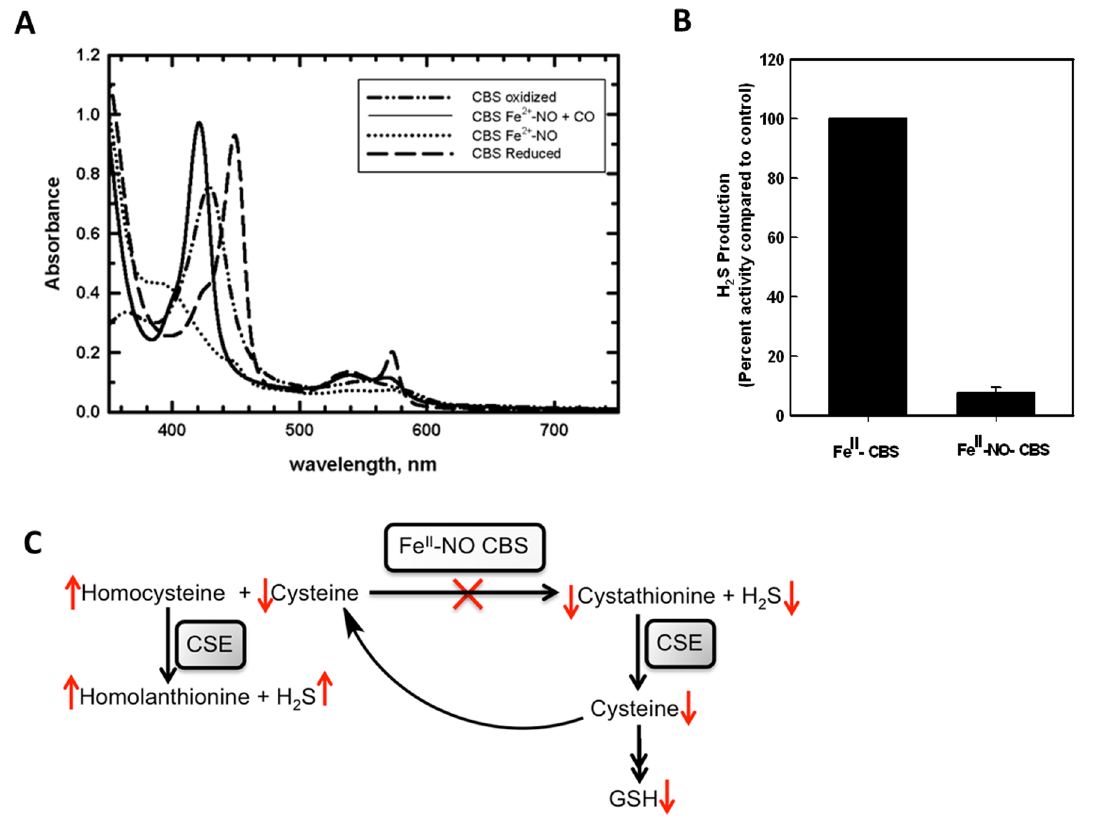
NN Figure 4. Reversible generation and metabolic consequences of Fe II -NO CBS. ( A ) Reduction of Fe III -CBS (10 m M) in 0.1 M HEPES buffer, -) with dithionite (3 mM) yields Fe II -CBS (–). The latter reacts with 10 mM nitrite to give Fe II -NO CBS ( …. ). The NO ligand is exchanged for pH 7.4, (- CO upon incubation of the reaction mixture for 10–15 min with CO (––). ( B ) Effect of NO binding to Fe II -CBS on H 2 S production was measured in 0.1 M HEPES buffer, pH 7.4 using cysteine (10 mM) and homocysteine (10 mM) as substrates. H 2 S generation was assesed using the lead sulfide precipitation assay. ( C ) Predicted metabolic consequences of Fe II -NO CBS formation. Inhibition of CBS by its nitrite reductase activity is predicted to decrease CBS-dependent